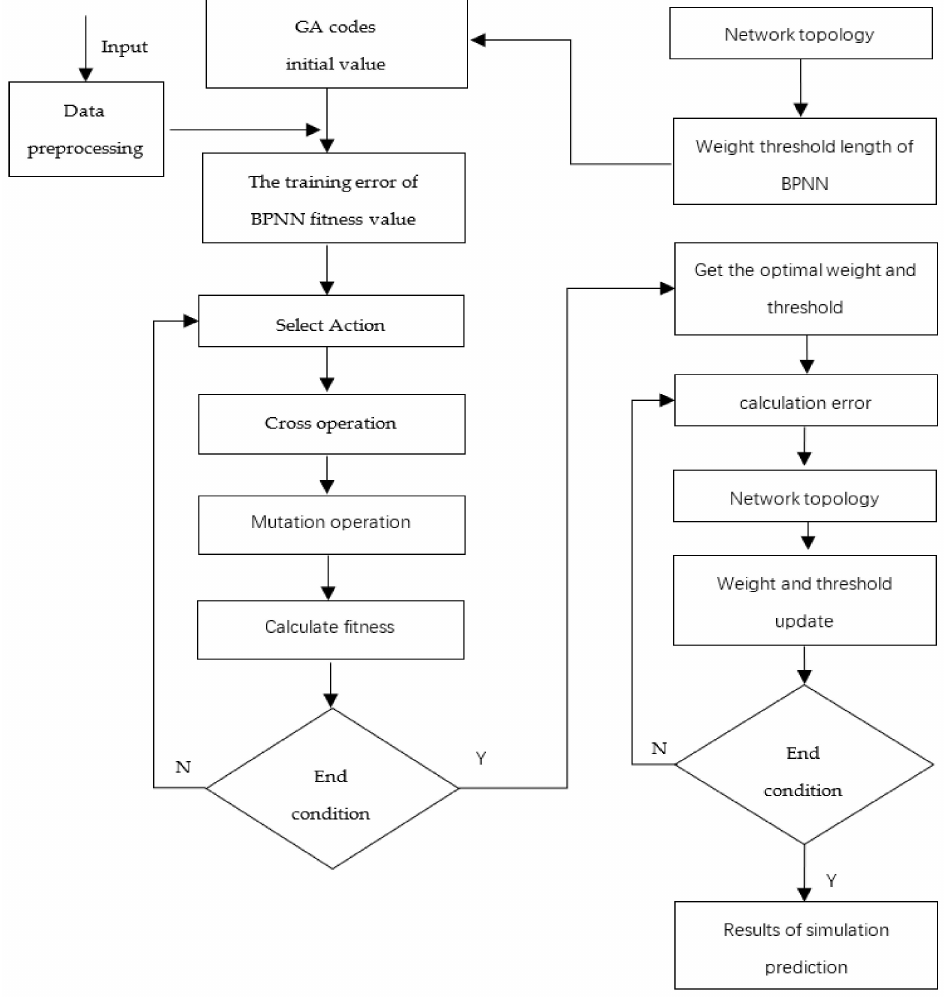
Figure 7. Flow chart of GA–BPNN.